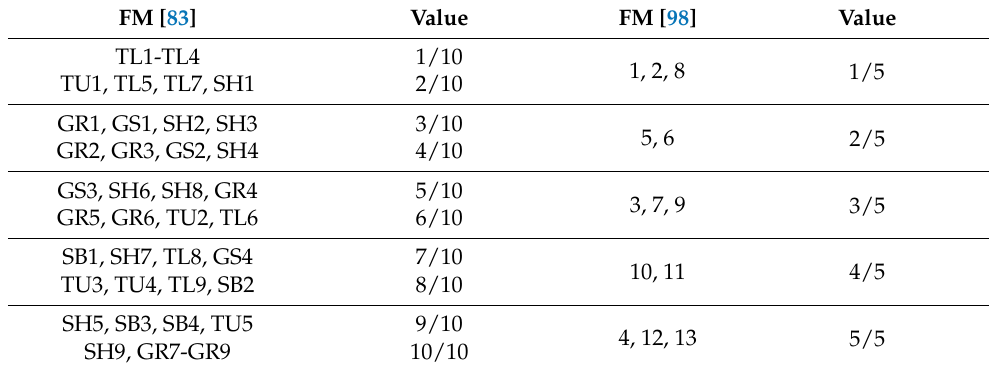
Table A6. Vegetation index assigned values.